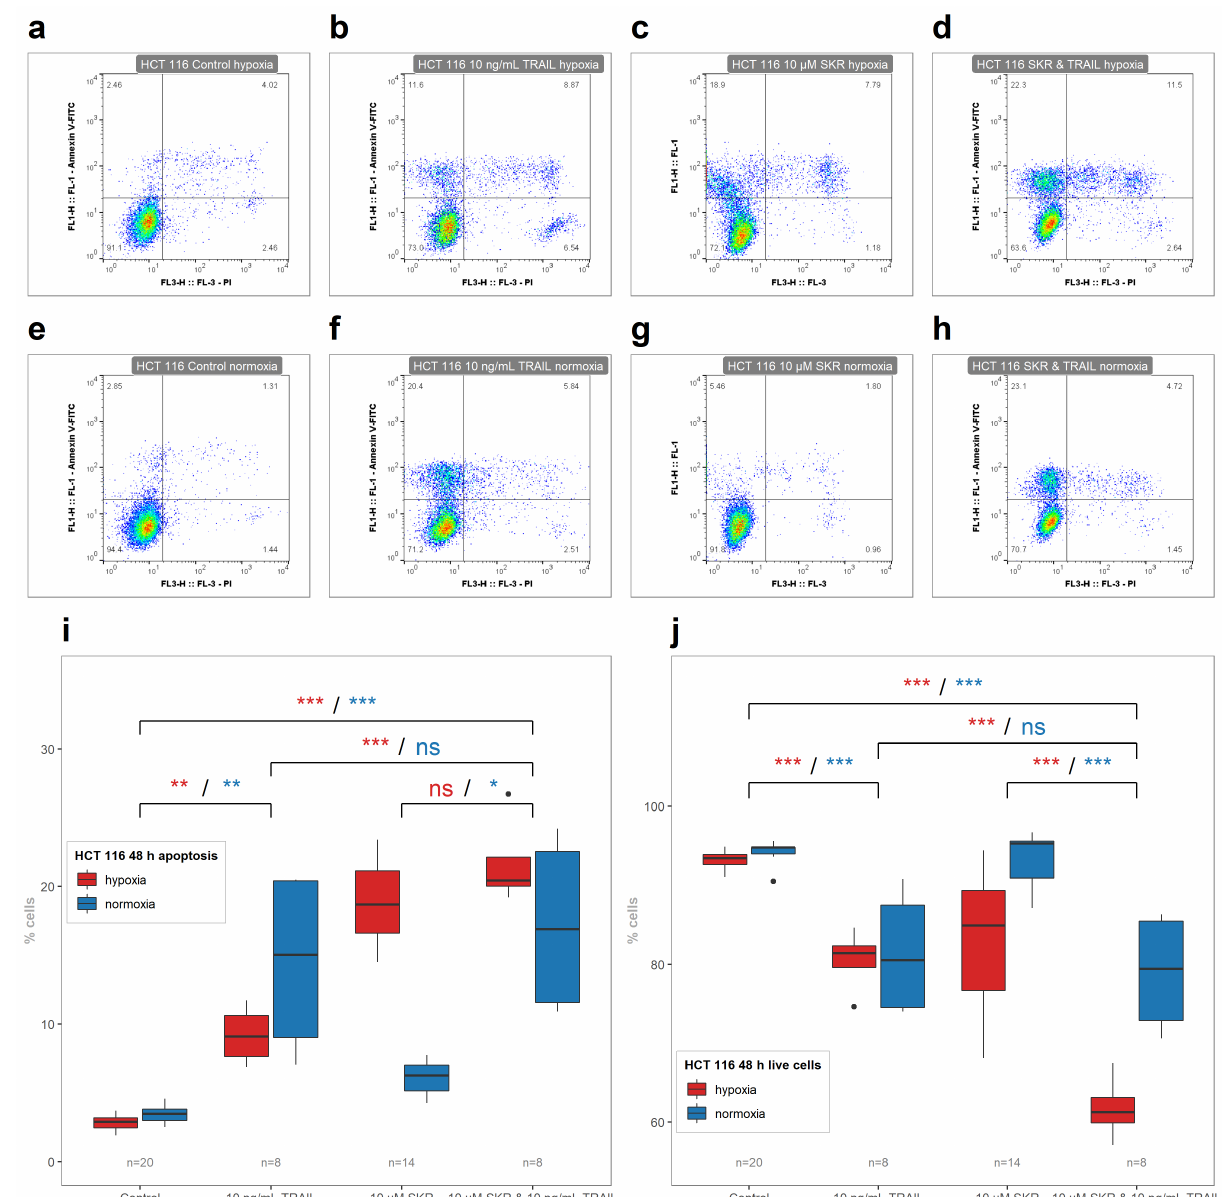
Figure 7. The effect of SKR in combination with TRAIL on the onset of apoptotic and live cells in HCT 116 cell line. ( a – h ) Representative FACS plots of debris-free singlets after SKR and TRAIL treatment in HCT 116 cell line. ( i ) Percentage of apoptotic cells after treatment with SKR and TRAIL after 48 h in HCT 116 cell line. ( j ) Percentage of live cells after treatment with SKR and TRAIL after 48 h in HCT 116 cell line. The experimental groups were compared with the matching control group or group, indicated with the line below marks. The color of the marks matches the cultivation conditions (hypoxia or normoxia). The number of samples (n) is noted in the plots. (* p < 0.05, ** p < 0.01, *** p < 0.001, ns—not